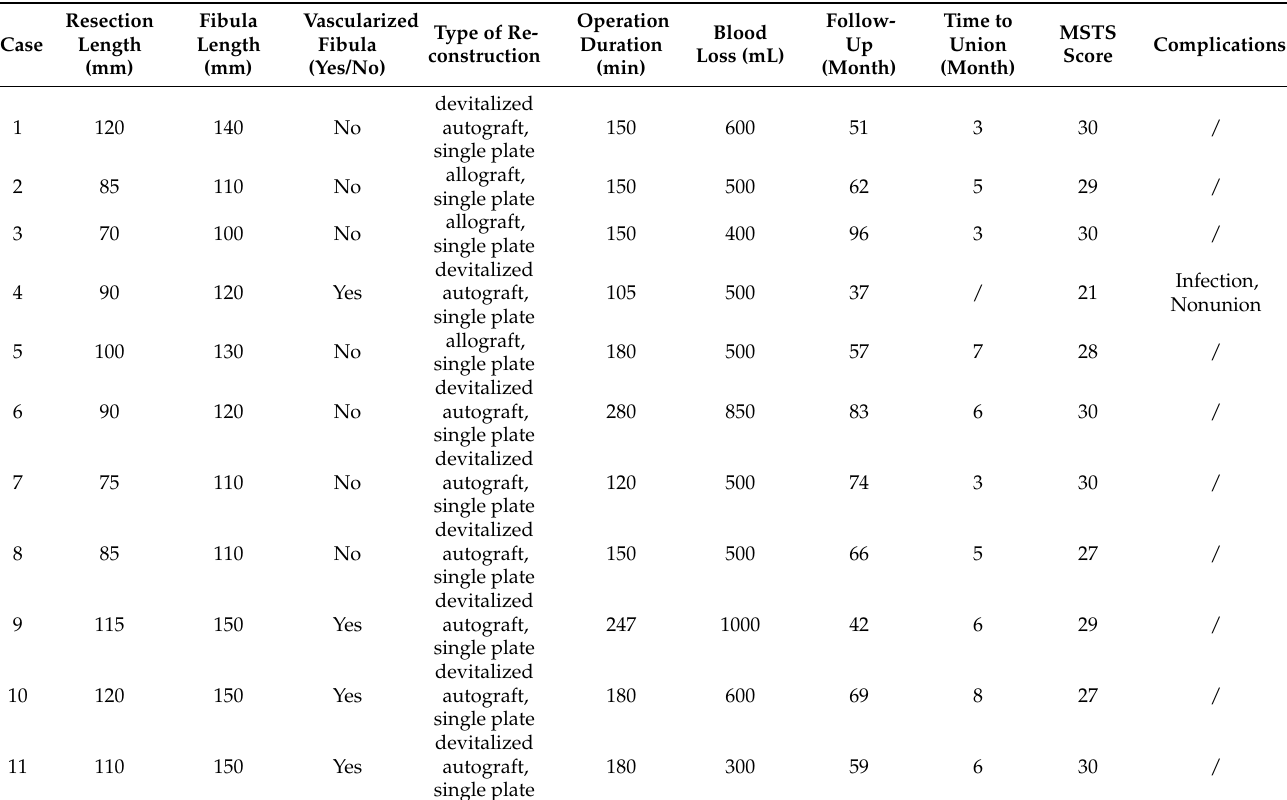
Table 2. Operative Details and